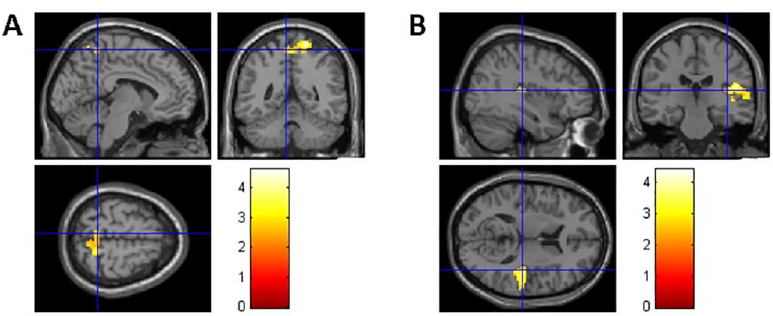
Fig 2. Brain areas showing stronger RSFC with left (A) and right SFG (B) seeds related to inhibition. The coordinatesof the cross in A and B are [–6, –48, 63] and [39,–24, 12], respectively.